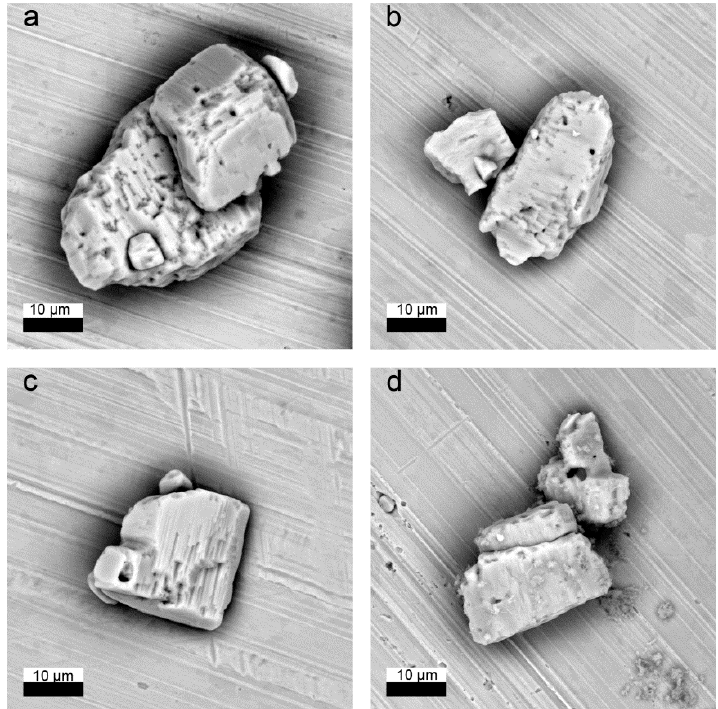
Figure 7. SEM micrographs of SL barite at the end of experiments with 0.005 mol/kg Sr ( a , c ) and 0.05 mol/kg Sr ( b , d ) in the aqueous solution at 90 °C. ( a , b ) S/L ratio = 5 g/kg, ( c , d ) S/L ratio = 0.5 g/kg.